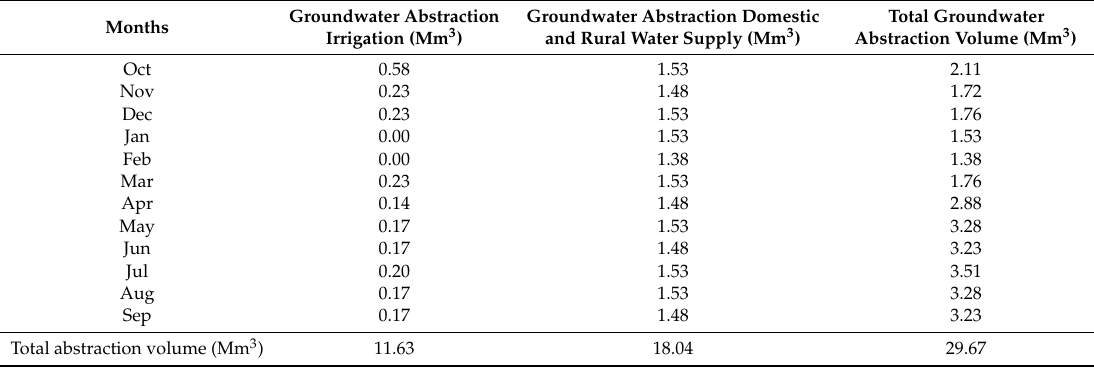
Table 7. Total volume groundwater abstraction for Chongwe River Catchment (obtained from the